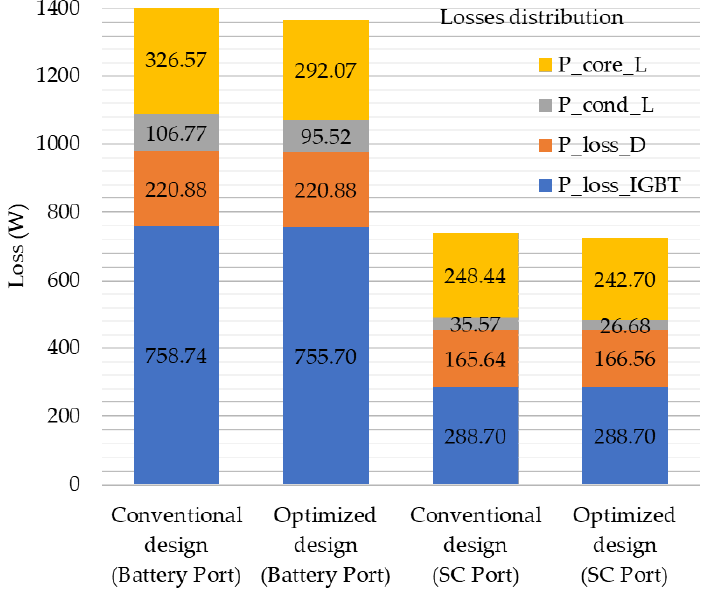
Figure 10. Losses distribution comparison at full load 30 kW.